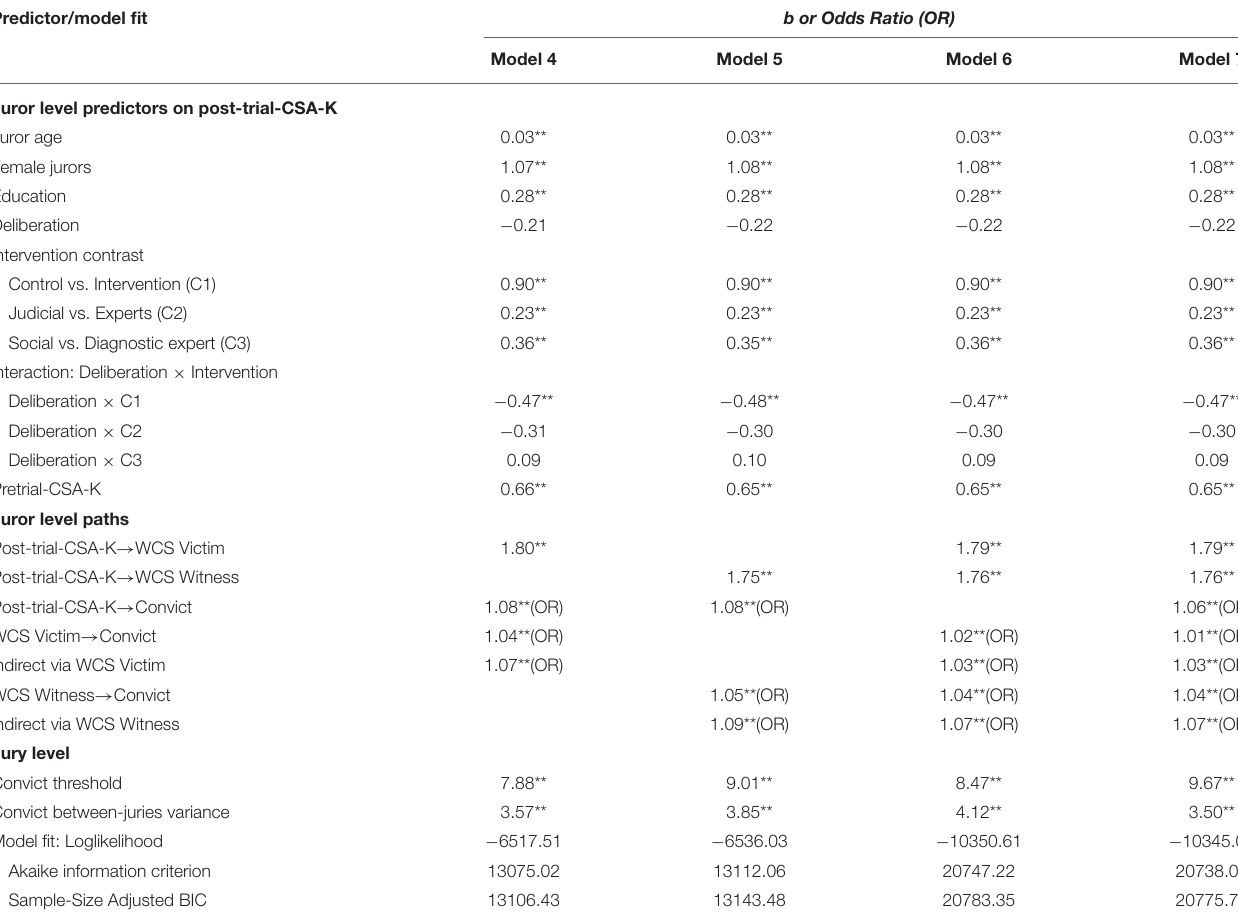
TABLE 6 | Multilevel mediation SEMs predicting conviction with post-trial CSA knowledge and mediators of witness credibility: unstandardized coefficients and odd ratios. Predictor/model